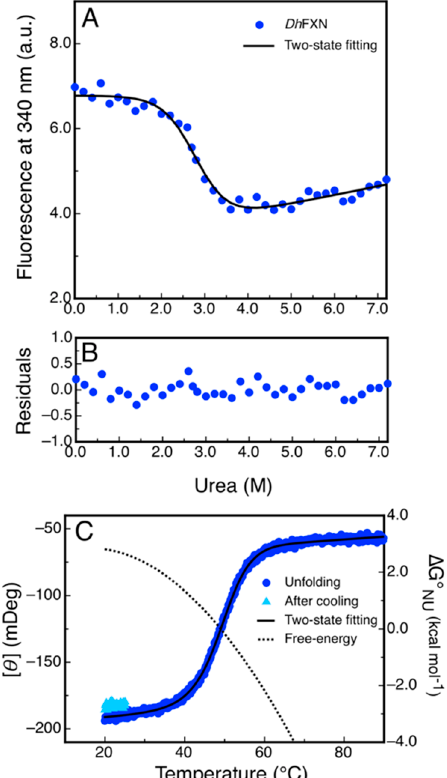
Figure 8. Equilibrium Unfolding of DdFXN. ( A ) Urea-induced unfolding monitored by tryptophan fluorescence at 340 nm. ( B ) Residuals of the fitting showed in A. ( C ) Temperature-induced unfolding followed by the far-UV CD signal at 220 nm. The unfolding curve is shown in blue and the signal recovered after cooling the sample and restarting the heating is shown cyan. The dotted curve corresponds to the difference in free energy calculate by means of a fitting of a two-state model to the data.